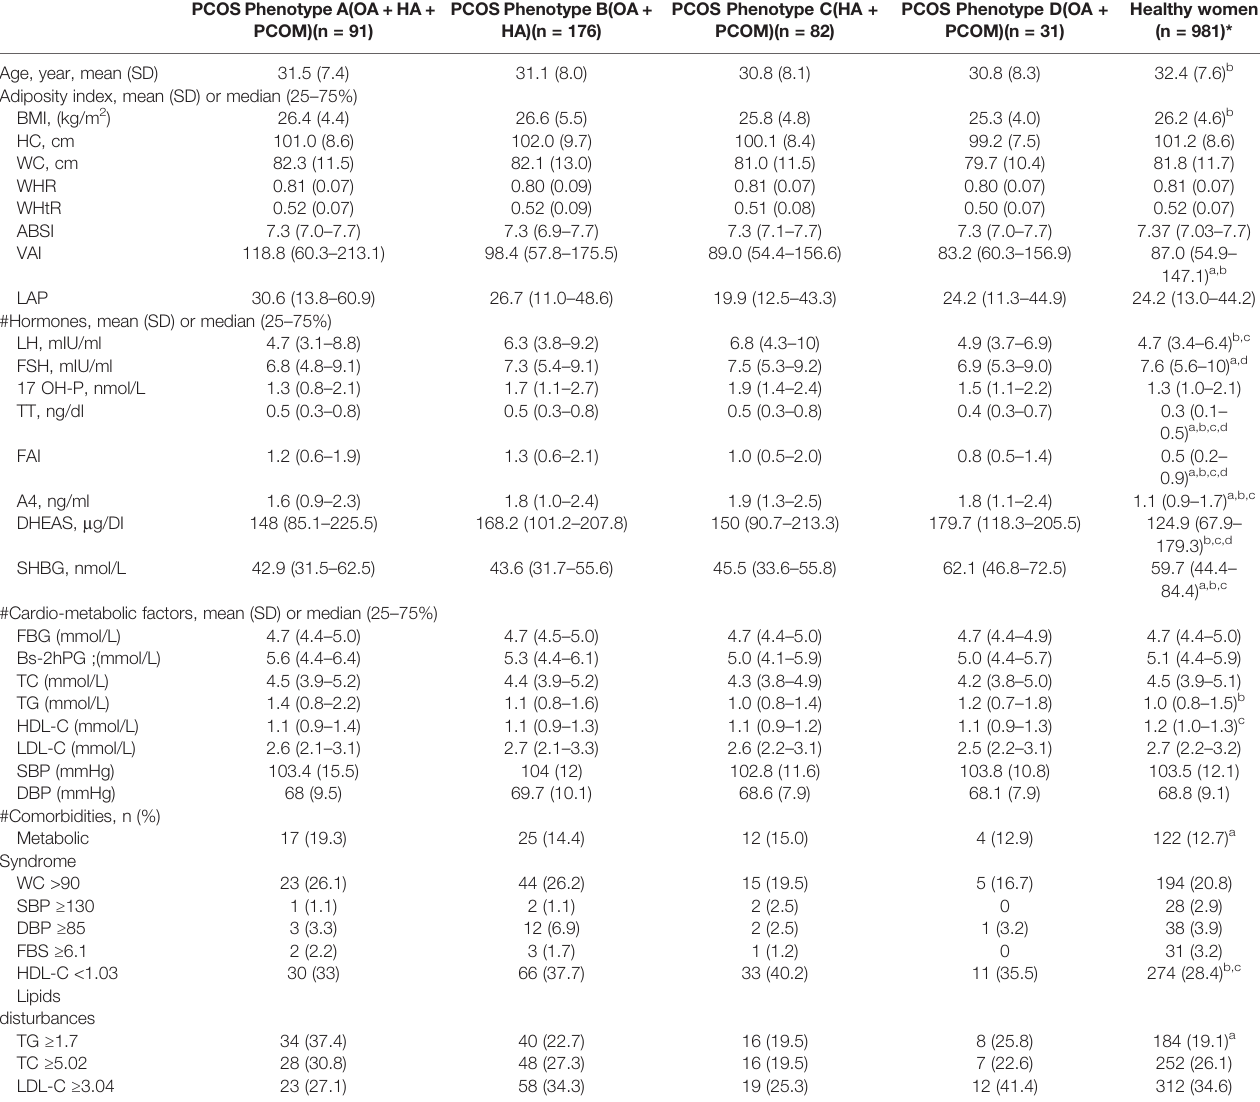
TABLE 2 | Features of the participants, classi fi ed to 4 phenotypical groups of PCOS and healthy women. PCOSPhenotype A(OA +HA+ PCOM)(n = 91)